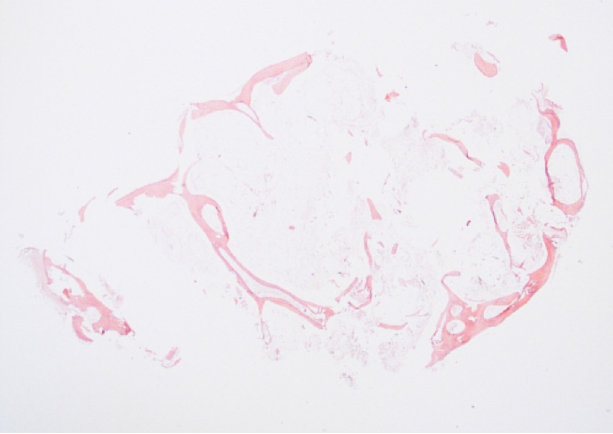
Fig. 2. Nodule with thin bony margins and adipose tissue (HES, 10